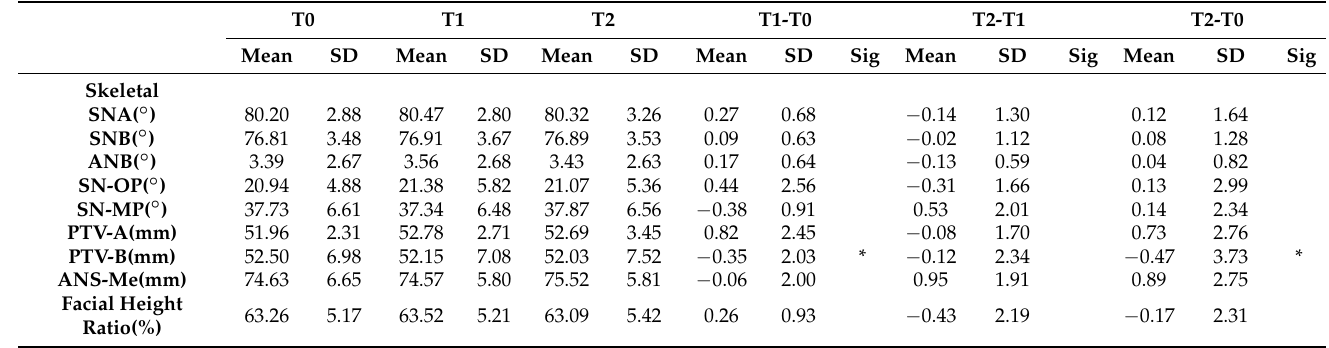
Table 4. Descriptive statistics of cephalometric measurements at pretreatment, post-treatment, postre- tention, pretreatment to post-treatment (T1-T0), post-treatment to postretention (T2-T1) and pretreat- ment to postretention (T2-T0) of mandibular arch distalization